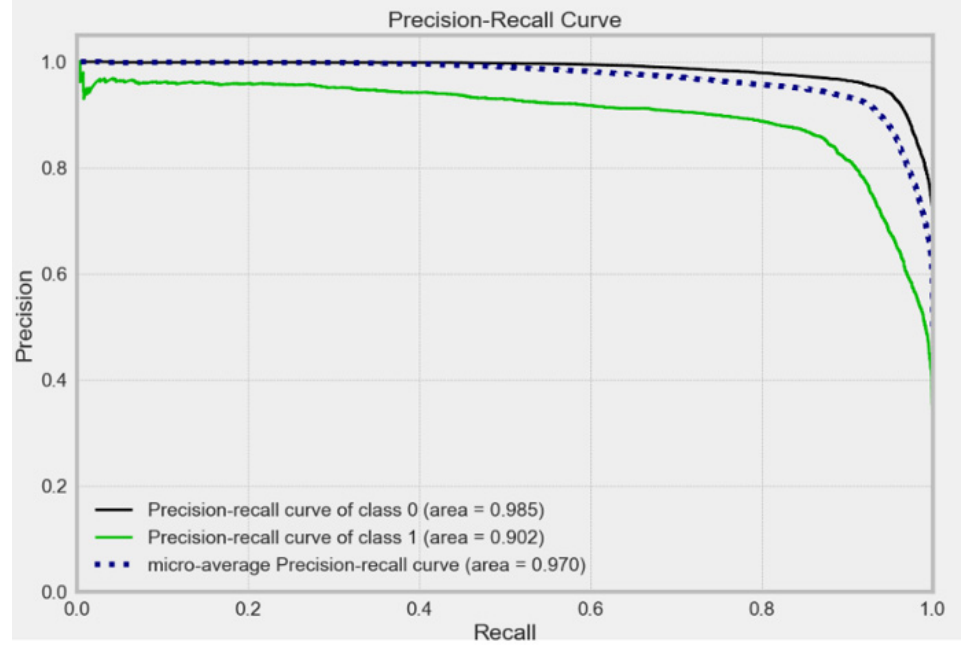
Figure 23. Precision–recall Curve for Catboost model.